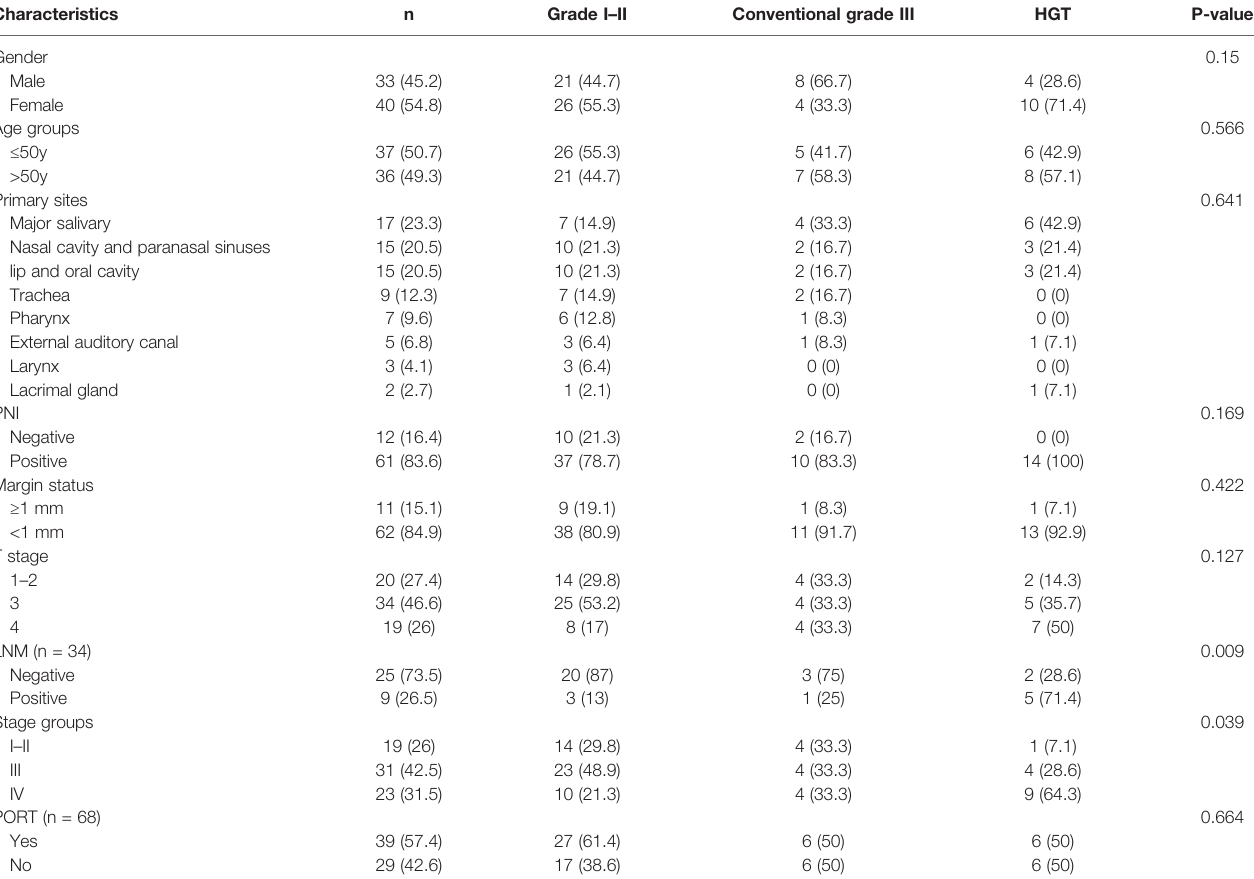
TABLE 4 | Correlation between tumor grading and clinicopathological characteristics.